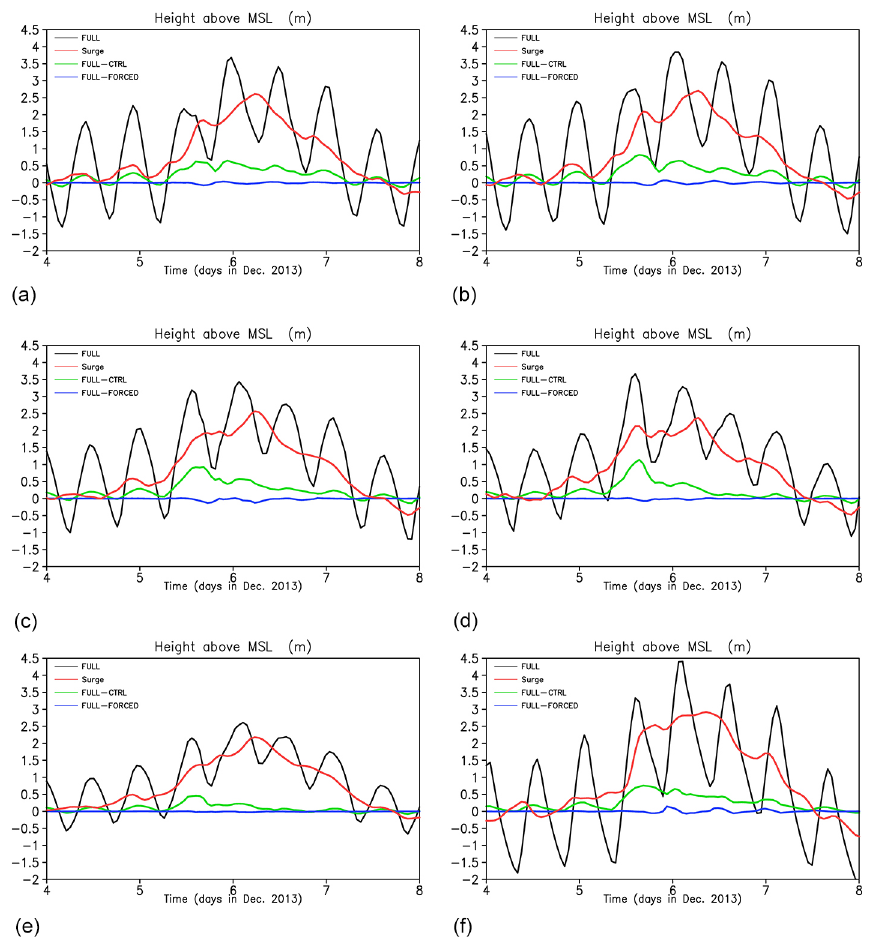
Figure 10. Time series of the mean sea level (MSL, black line); storm surge (red line); differences between the storm surge from FULL and CTRL runs (FULL–CTRL, green line); differences between the FULL and FORCED runs (FULL–FORCED, blue line) at six stations ST1–ST6 (see Fig. 1 for